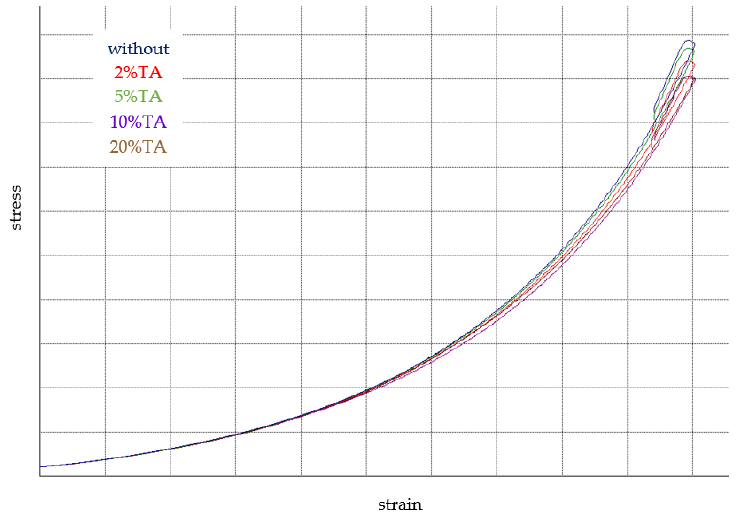
Figure 6. The mechanical parameters of hydrogel without immersion in tannic acid solution and of hydrogel immersed in TA solution at 2%, 5%, 10%, and 20% concentration; for p < 0.05, no statisti- cally significant differences were observed (Emod —compressive modulus, σmax— maxium ten- sion, dl — percentage deformation at maximum tension).